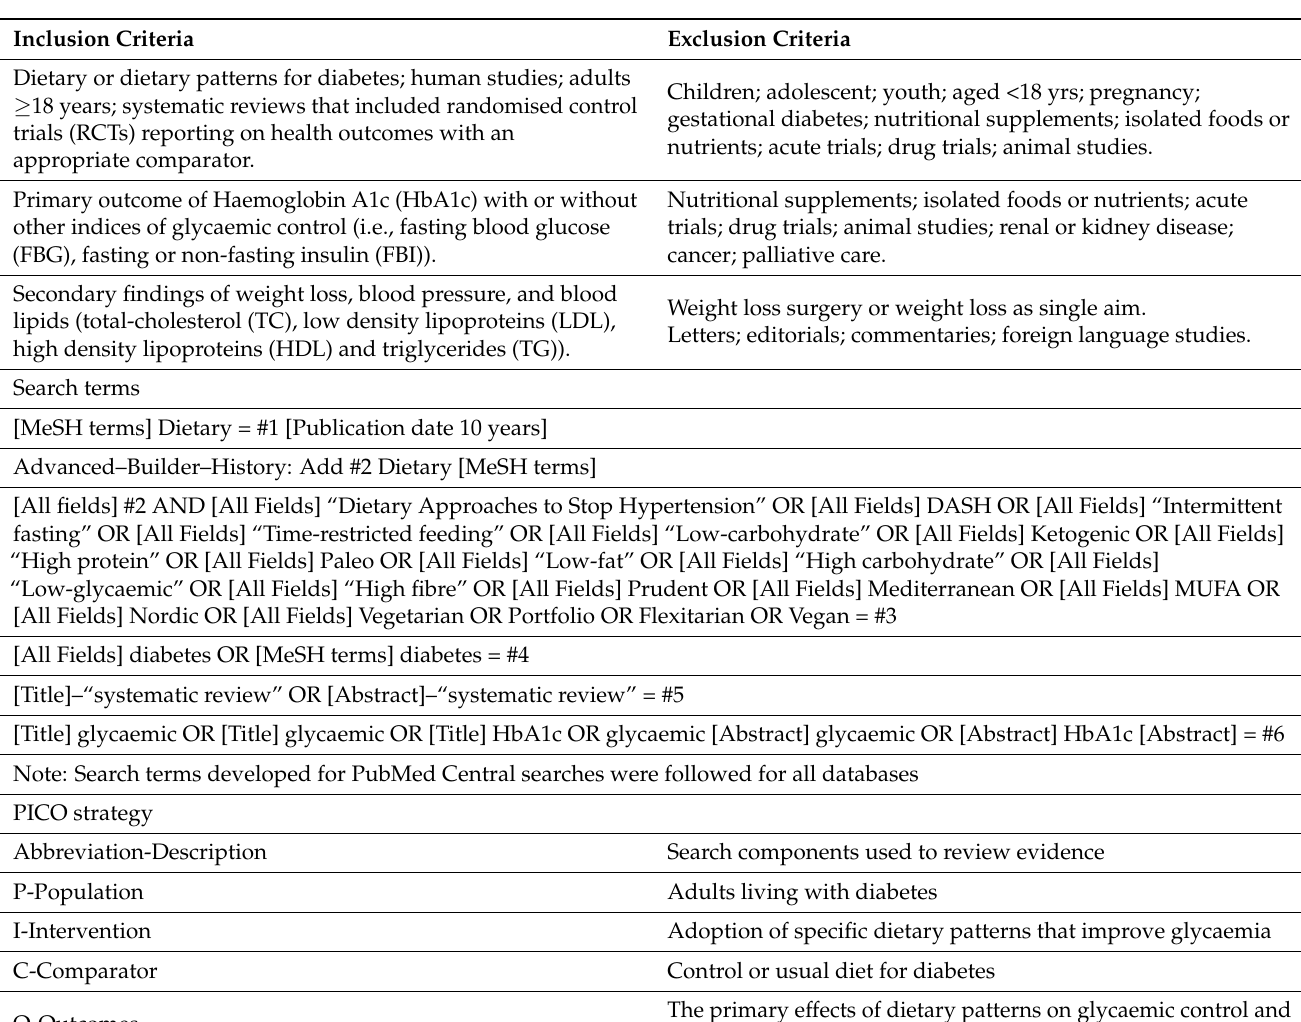
Table 2. Final inclusion and exclusion criteria, search terms, and PICO strategy used for data